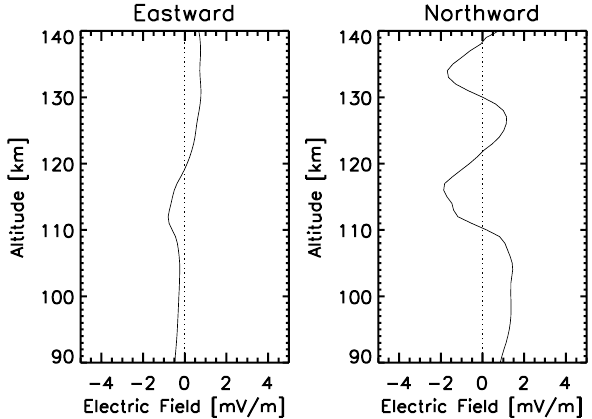
Fig. 6. Profiles of each component of the electric field obtained from the simulation at t = 3600s of Yokoyama et al.